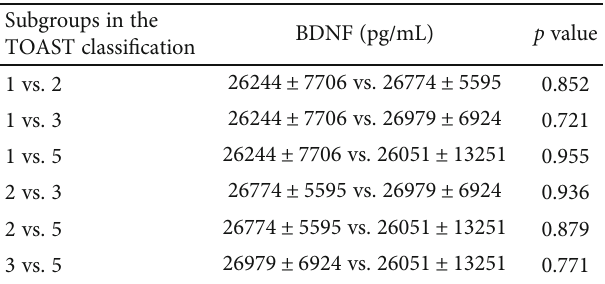
Table 3: The comparison of subgroups ( n = 73 ) in regard to the TOAST classi fi cation and BDNF level ( mean ± SD ). Subgroups in the TOAST classi fi